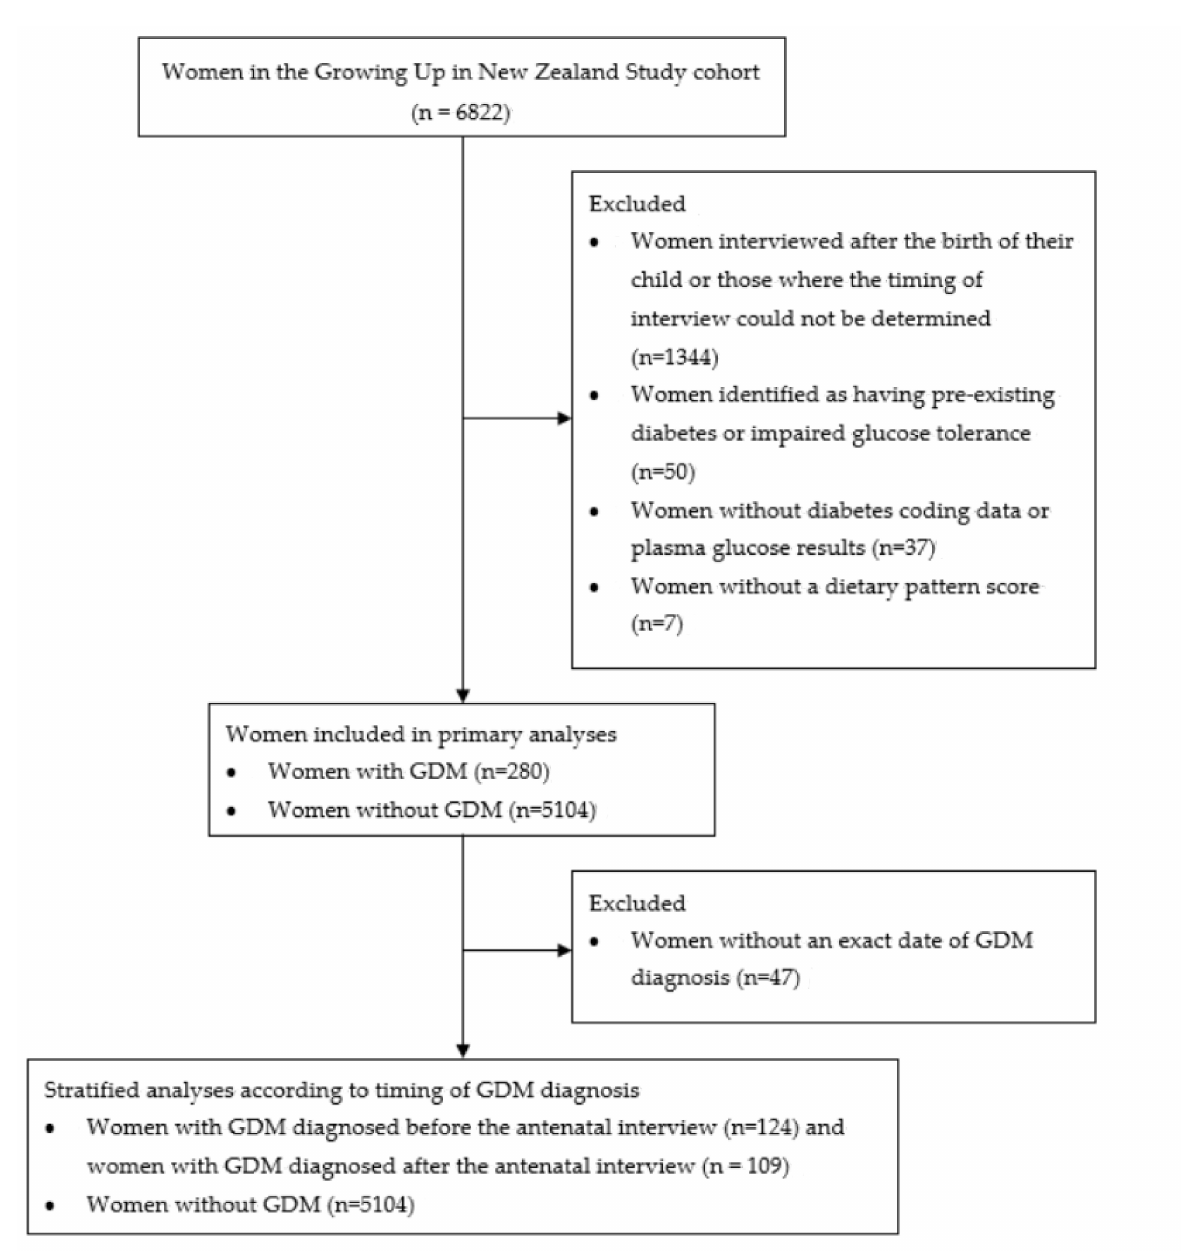
Figure 1. Flowchart showing selection of participants included in primary and secondary analyses of dietary patterns and dietary adaptations in women with and without GDM from the Growing Up in New Zealand